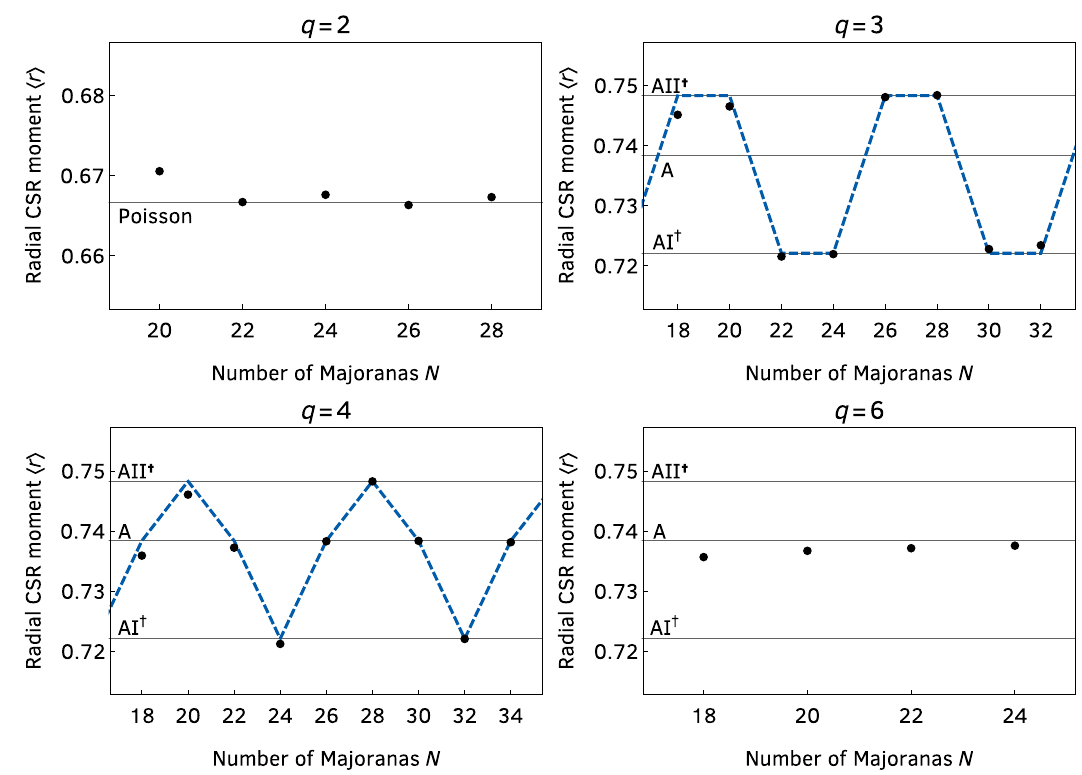
FIG. 9. First radial moment h r i of the complex spacing ratio (CSR) distribution as a function of the number of Majoranas, N , for the q ¼ 2 , 3, 4, 6 nHSYK model. The dots are the results of exact numerical diagonalization, the horizontal solid lines are the values of h r i for the three universal bulk statistics (A, AI † , and AII † ), and the dashed curve follows the classification scheme of Table II. For q ¼ 2 , h r i goes to the Poisson value 2 = 3 as N increases, showing that no RMT correlations exist around the Heisenberg time. For q ¼ 6 , the three classes realized for different values of N all have the same bulk correlations (those of class A). We see excellent agreement between the nHSYK results and the RMT predictions, except for the smaller values of N , where finite-size effects are more